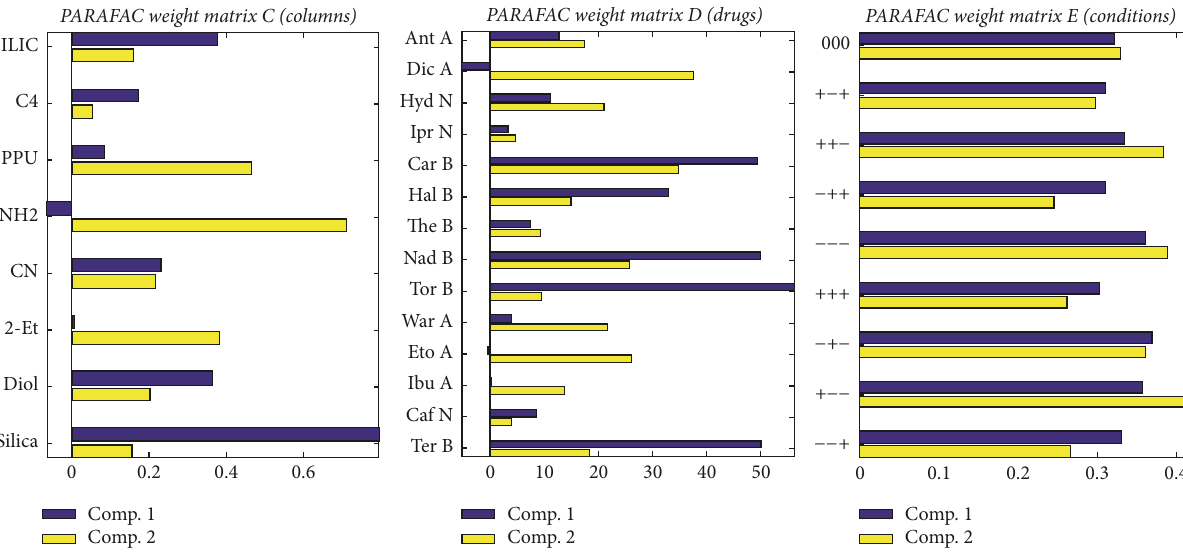
Figure 5: Weight matrices 𝐶 (8, 2), 𝐷 (14, 2), and 𝐸 (9, 2) of the PARAFAC decomposition with two